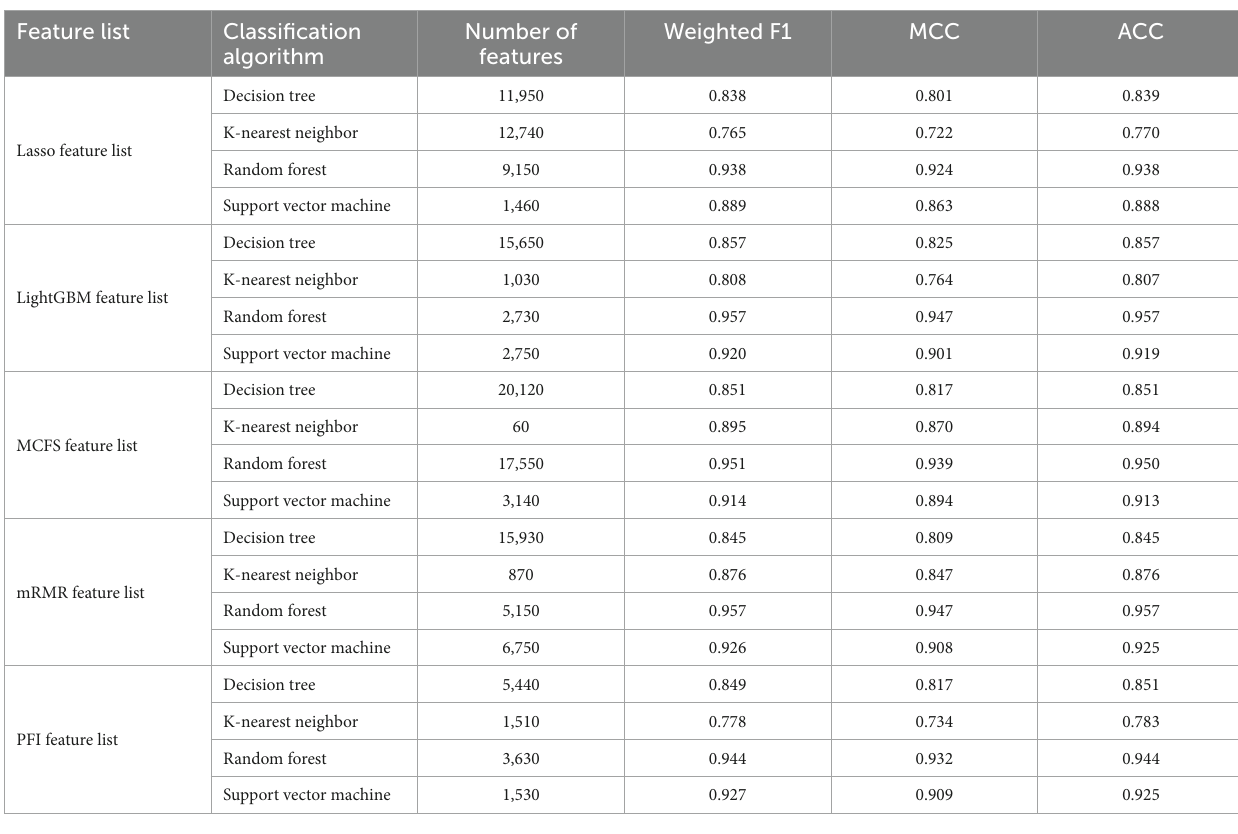
TABLE 3 Performance of the optimal classifiers based on different classification algorithms and feature lists.